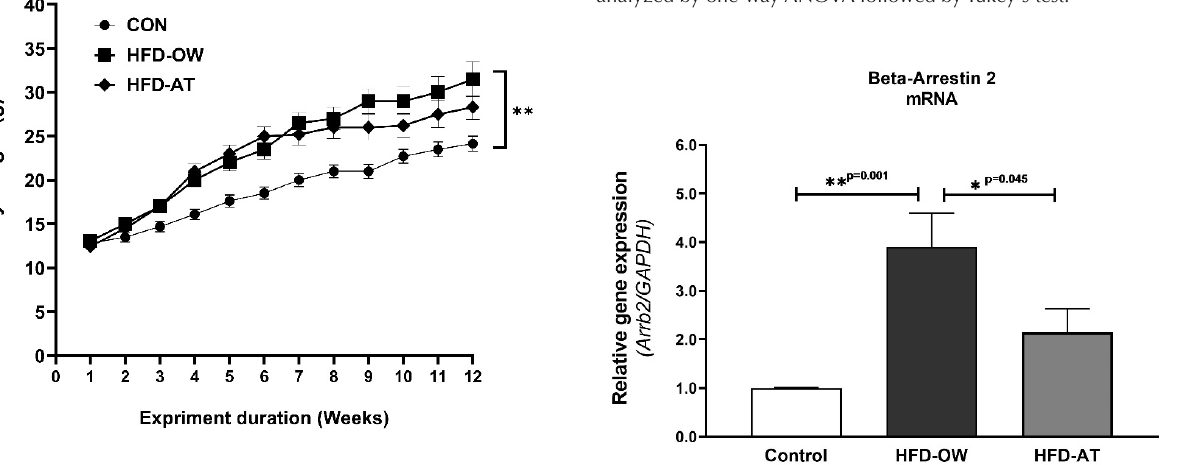
Figure 4. Relative gene expression of beta arrestin 2 (Arrb2) in the study groups. HFD-OW: High-fat diet-induced overweight; HFD-AT: high fat diet with aerobic training. Data are presented as mean±SEM. Data were analyzed by one-way ANOVA followed by Tukey's